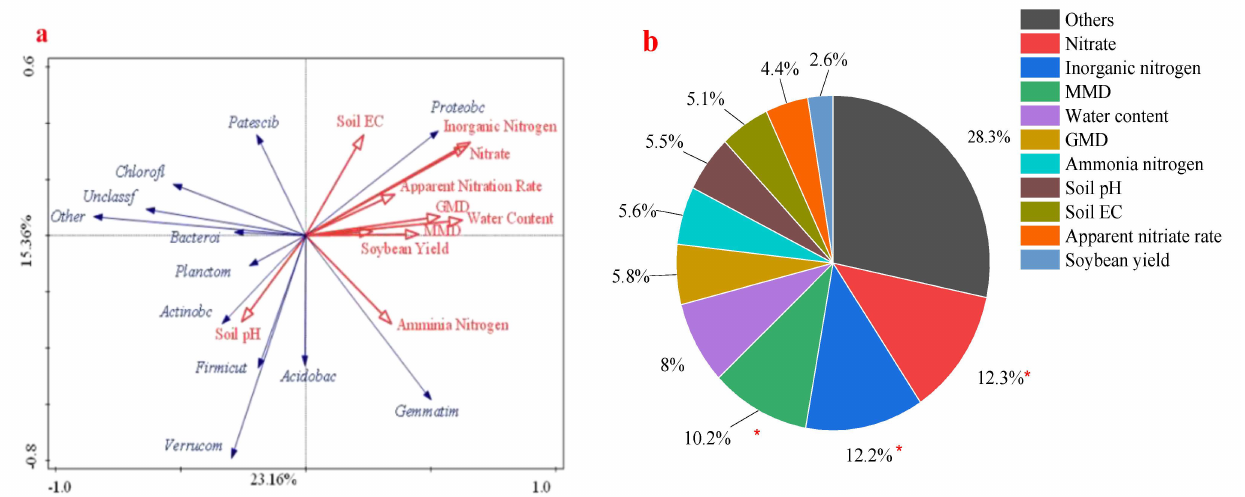
Figure 9. Redundancy analysis (RDA) among the soil’s properties and bacterial community ( a ) and explanatory factor analysis ( b ). The red line in figure a represents environmental factors and the blue one represents bacterial species. GMD: Geometric mean diameter; MMD: Mean mass diameter. The * in Figure 9b represents the significant influence at p <